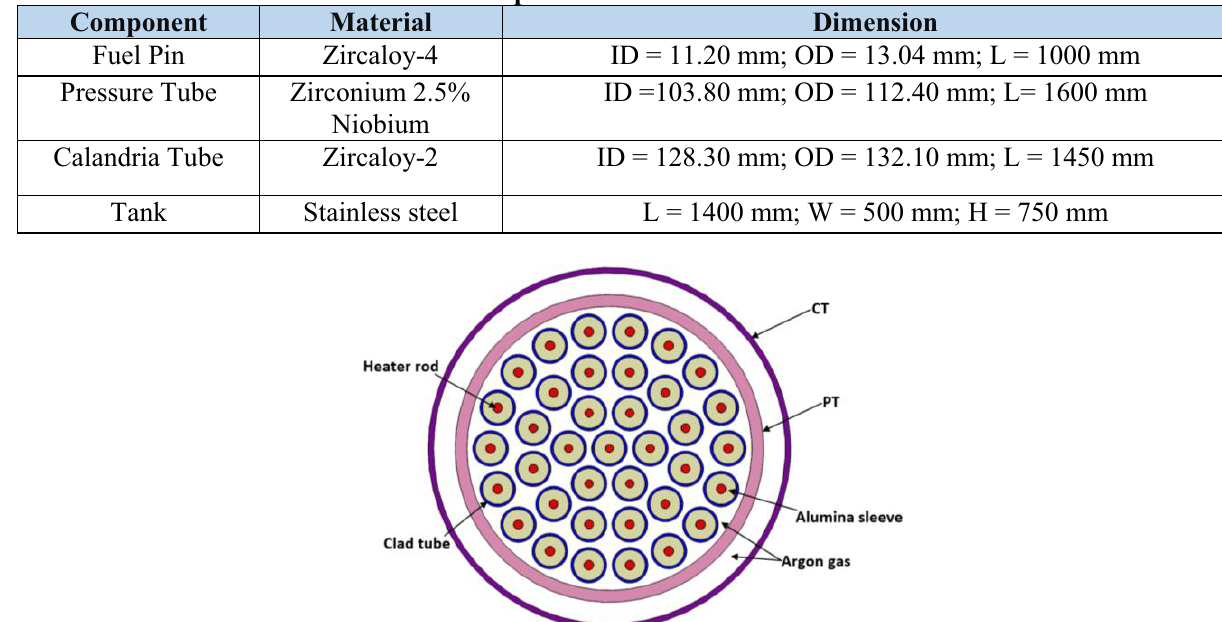
Figure 1: Schematic of the experimental facility Table 1: Specifications of the test-section